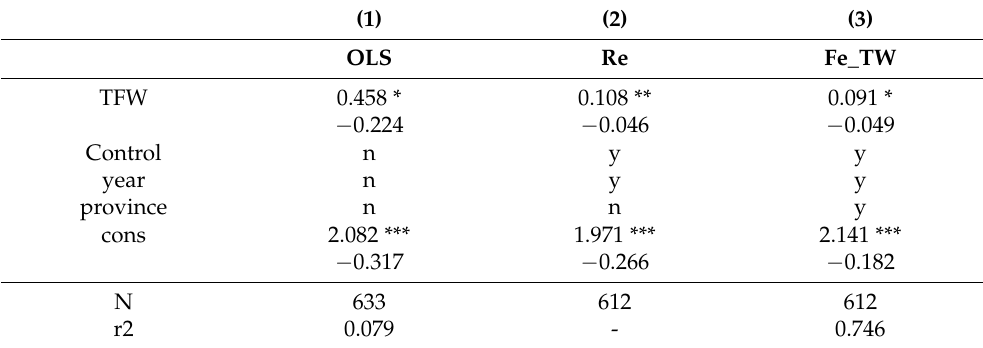
Table 2. Baseline regression results of the impact of TFW on carbon density of collective forests.